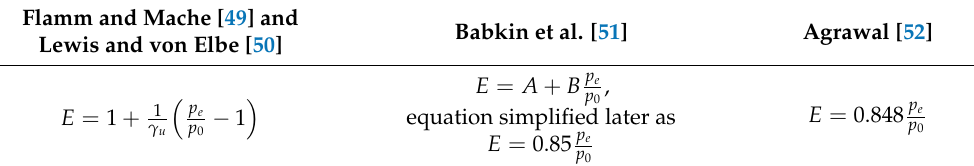
Table 2. Approximate relationships for calculating the expansion coefficients, by data referring to the isochoric combustion of flammable mixtures. Flamm and Mache [49] and